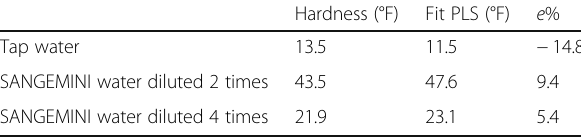
Table 3 Prediction of hardness values in water samples by the PLS model, from UV-vis spectra measurements, using